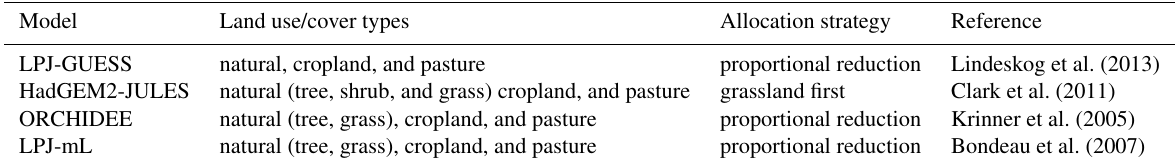
Table 1. Examples of allocation rules at grid cell level to implement agricultural land in different TBMs.